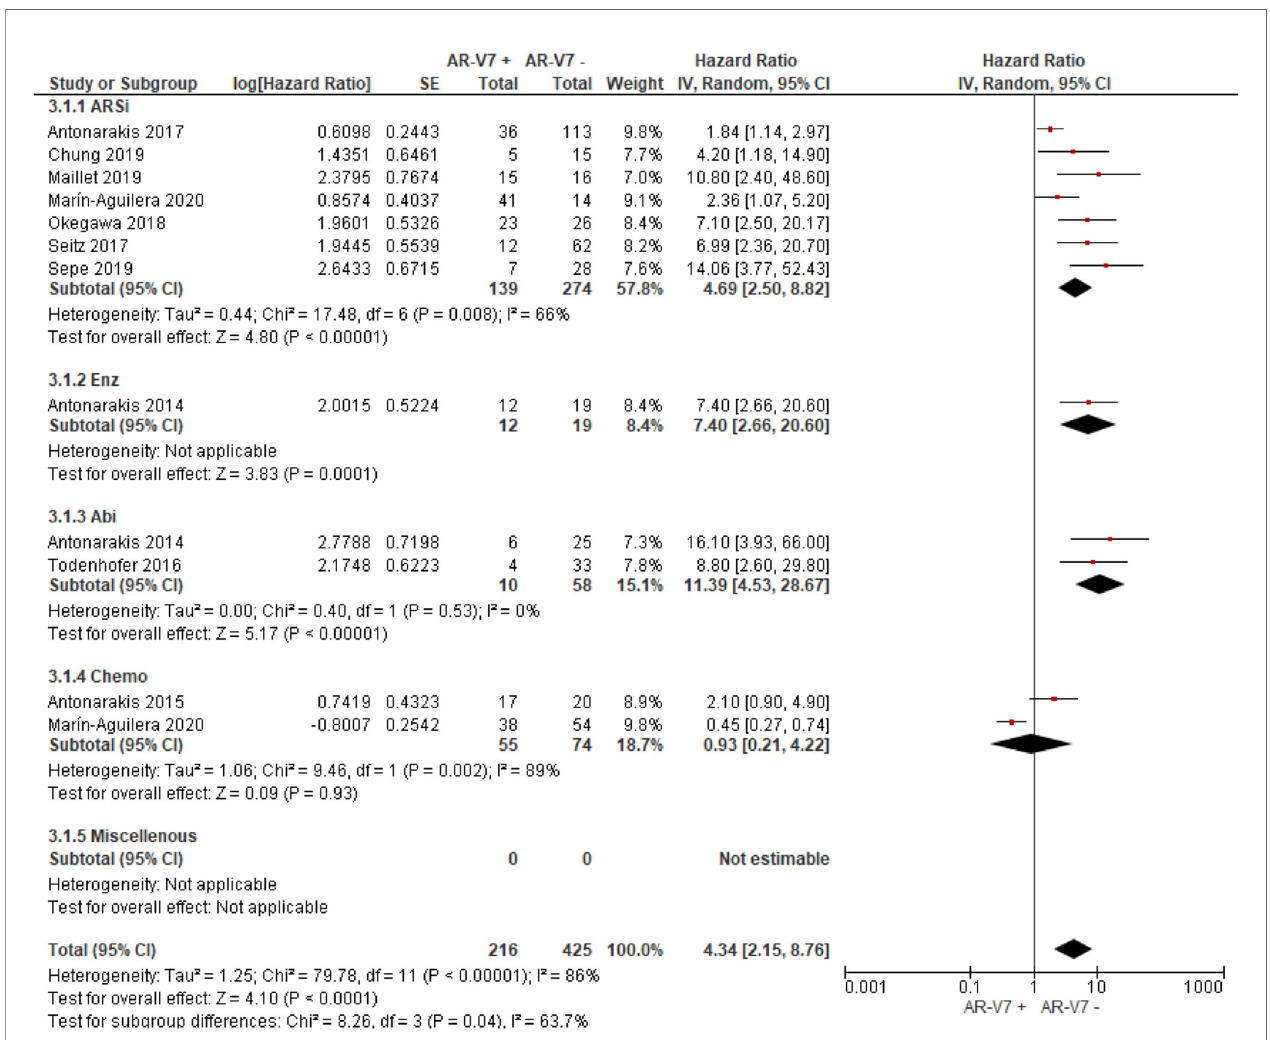
FIGURE 4 | Forest plot of hazard ratios (HRs) for association of liquid biopsy AR-V7 status with PSA-PFS in all studies. Pooled HRs were calculated using random effect model. AR-V7, androgen receptor splice variant 7; CI, con fi dence interval and bars indicate 95% CIs. Subgroup analysis (ARSi, enzalutamide or abiraterone; Enz, enzalutamide; Abi, abiraterone; Chemo, taxane based chemotherapy; Miscellaneous, treatments that do not belong to above treatments or not clearly de fi ned) were